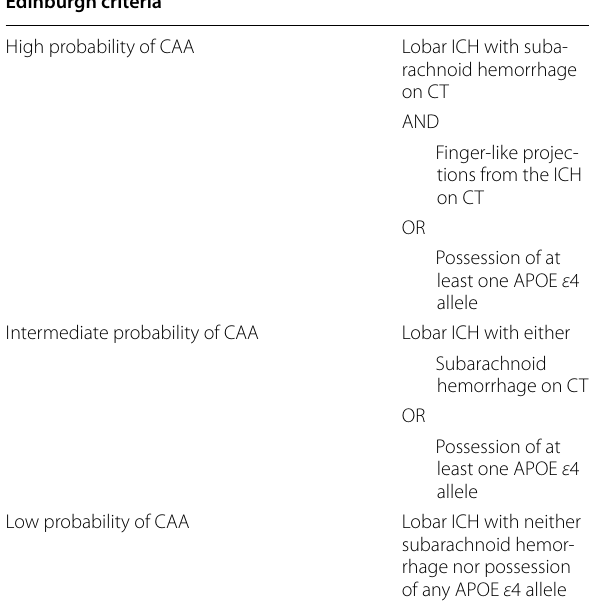
CAA Cerebral Amyloid Angiopathy, ICH Intracerebral Hemorrhage, APOE Apolipoprotein E Table 4 The modified Boston criteria for predicting the probability of Chronic Amyloid Angiopathy (CAA) as the underlying cause of ICH